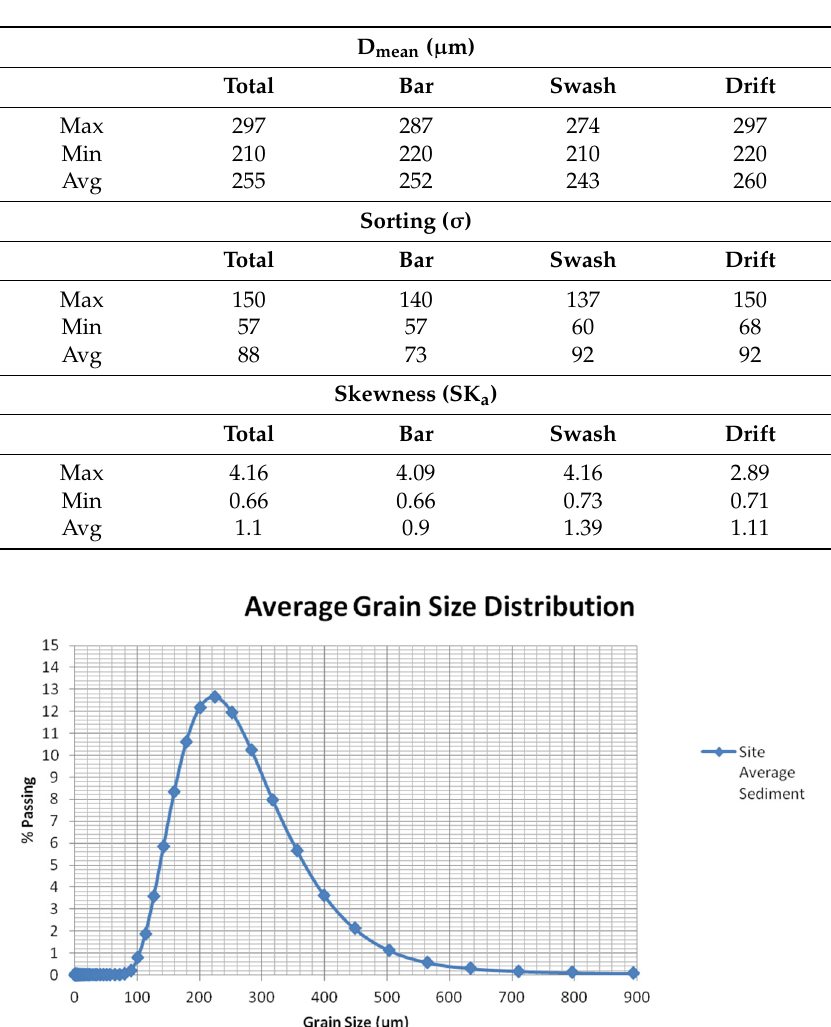
Table 2. Summary stats by location.